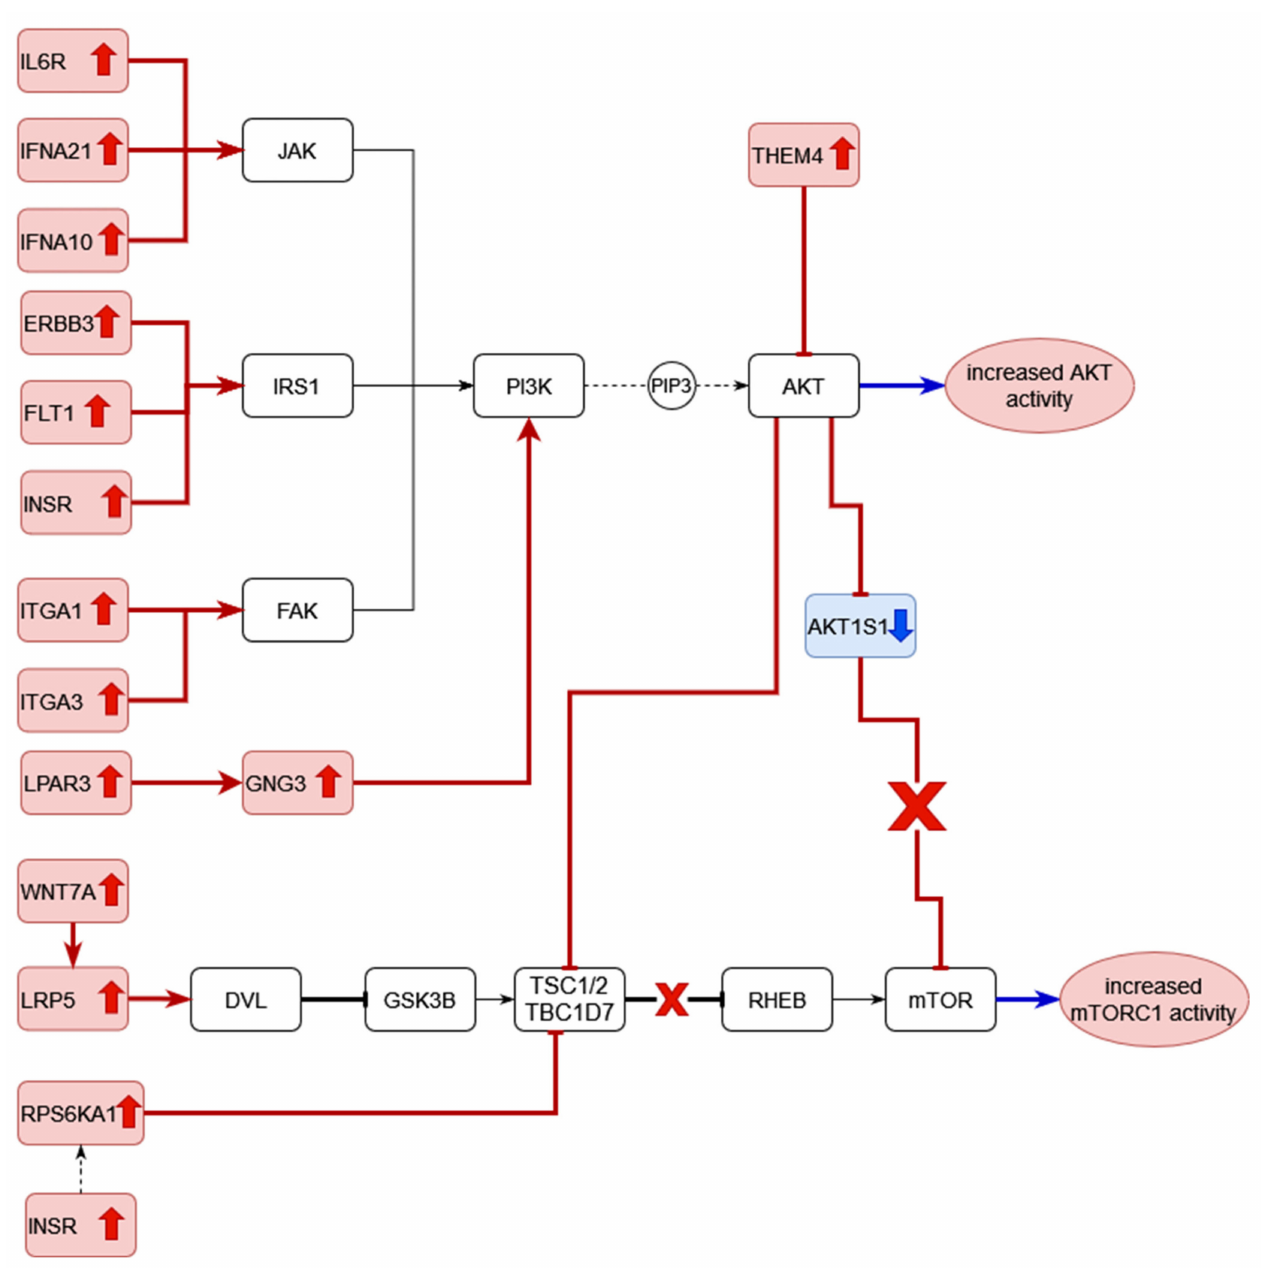
Figure 21. RA CD8 + Temra differentially expressed genes in the PI3K-AKT pathway and the mTOR pathway. Red up arrows indicate upregulation. Red arrows indicate the effect of the differentially regulated genes on their targets, where T shaped arrows indicate inhibition and normal arrows indicate activation. Dotted arrows indicate the presence of intermediate steps between the two connected proteins. Red crosses show the interactions that are lost in the RA CD8 + Temra cells due to inhibition or downregulation of the upstream